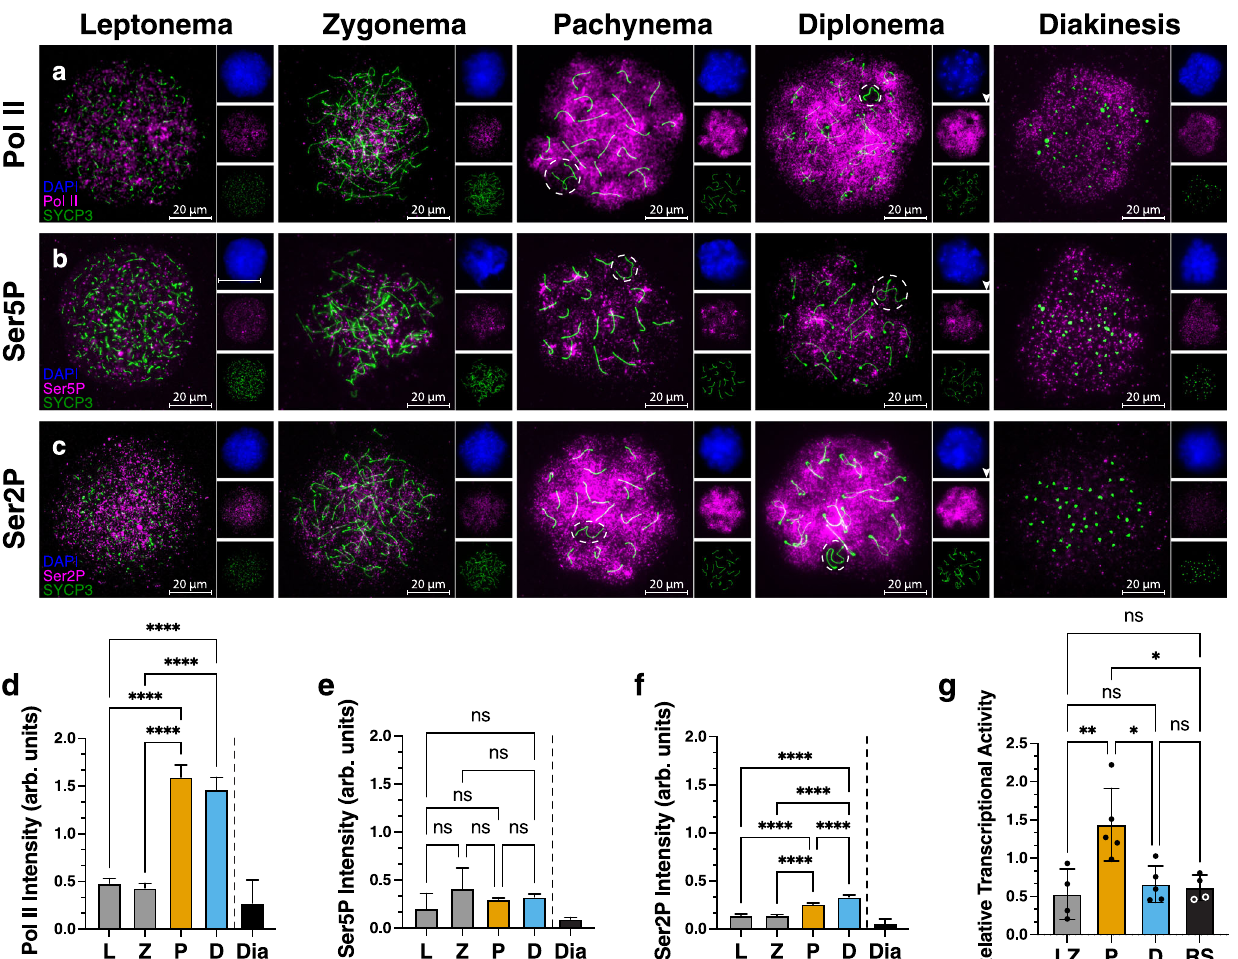
Fig.1|TranscriptionallyactiveisoformofRNApolymeraseII,Ser2P,isenriched in pachynema and diplonema. a – c Immuno fl uorescence staining on spread meiotic spermatocyte preparations from wild-type C57Bl/6 mice using anti- bodies against SYCP3 (green) and Pol II ( a ), Ser5P ( b ), and Ser2P ( c